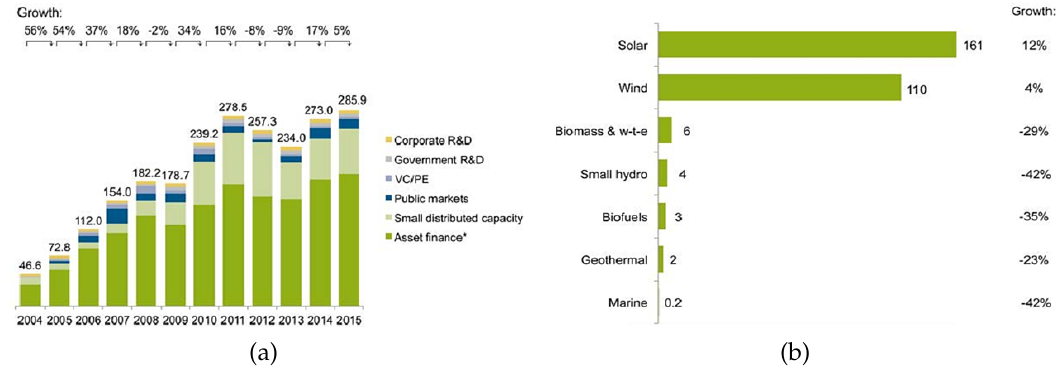
Figure 3. Real MS-stability regions: ( a ) new global investment in RE by asset class; ( b ) new global investment in RE by sector, 2015, and growth in 2014; $BN